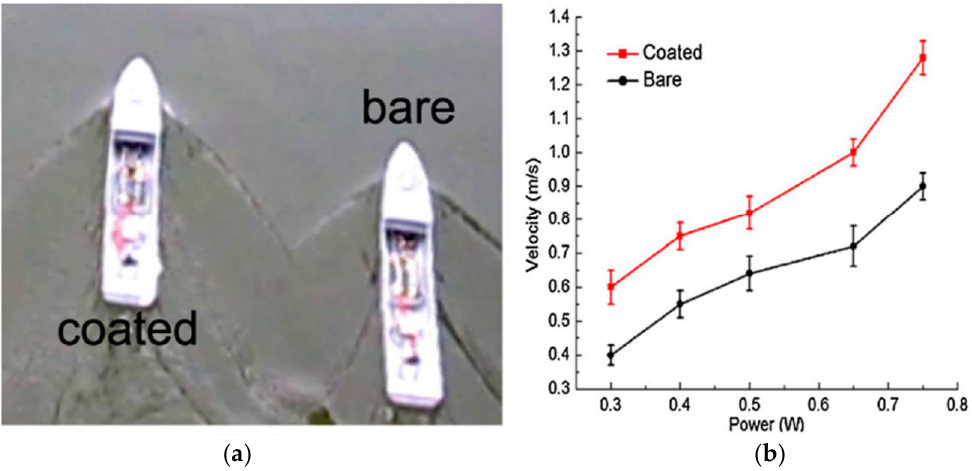
Figure 17. ( a ) Sailing experiment at a power supply of 0.5 W; ( b ) velocity of bare/coated model versus power supply. Reprinted with permission from Ref [94]. Copyright 2018 Elsevier.